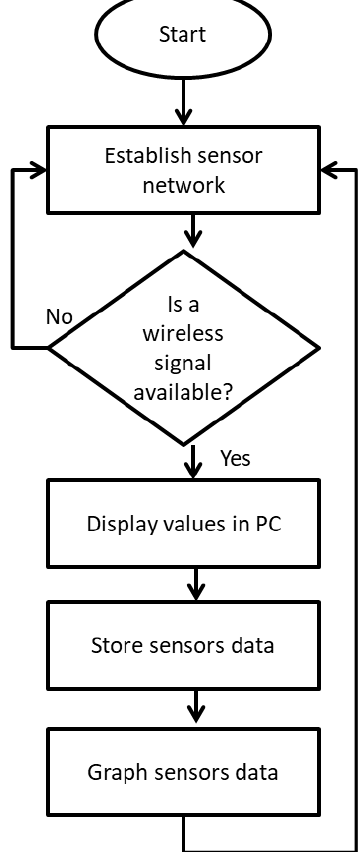
Figure 4. Flow diagram of communication software with low-cost open-source hardware (LC OSH).